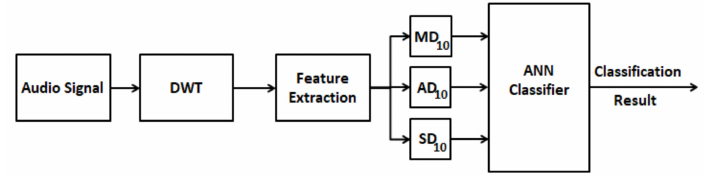
Figure 12. Schematic of the wavelet-based method for fault detection and